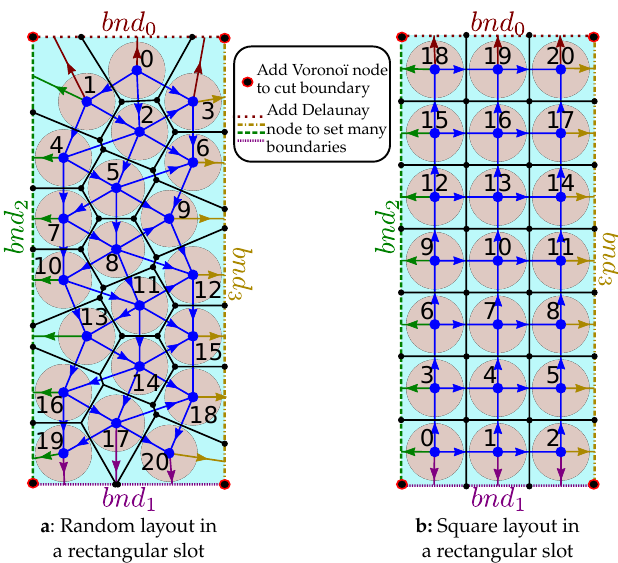
Figure 4. Several boundary conditions for a rectangular slot with a random layout ( a ) and a square layout ( b